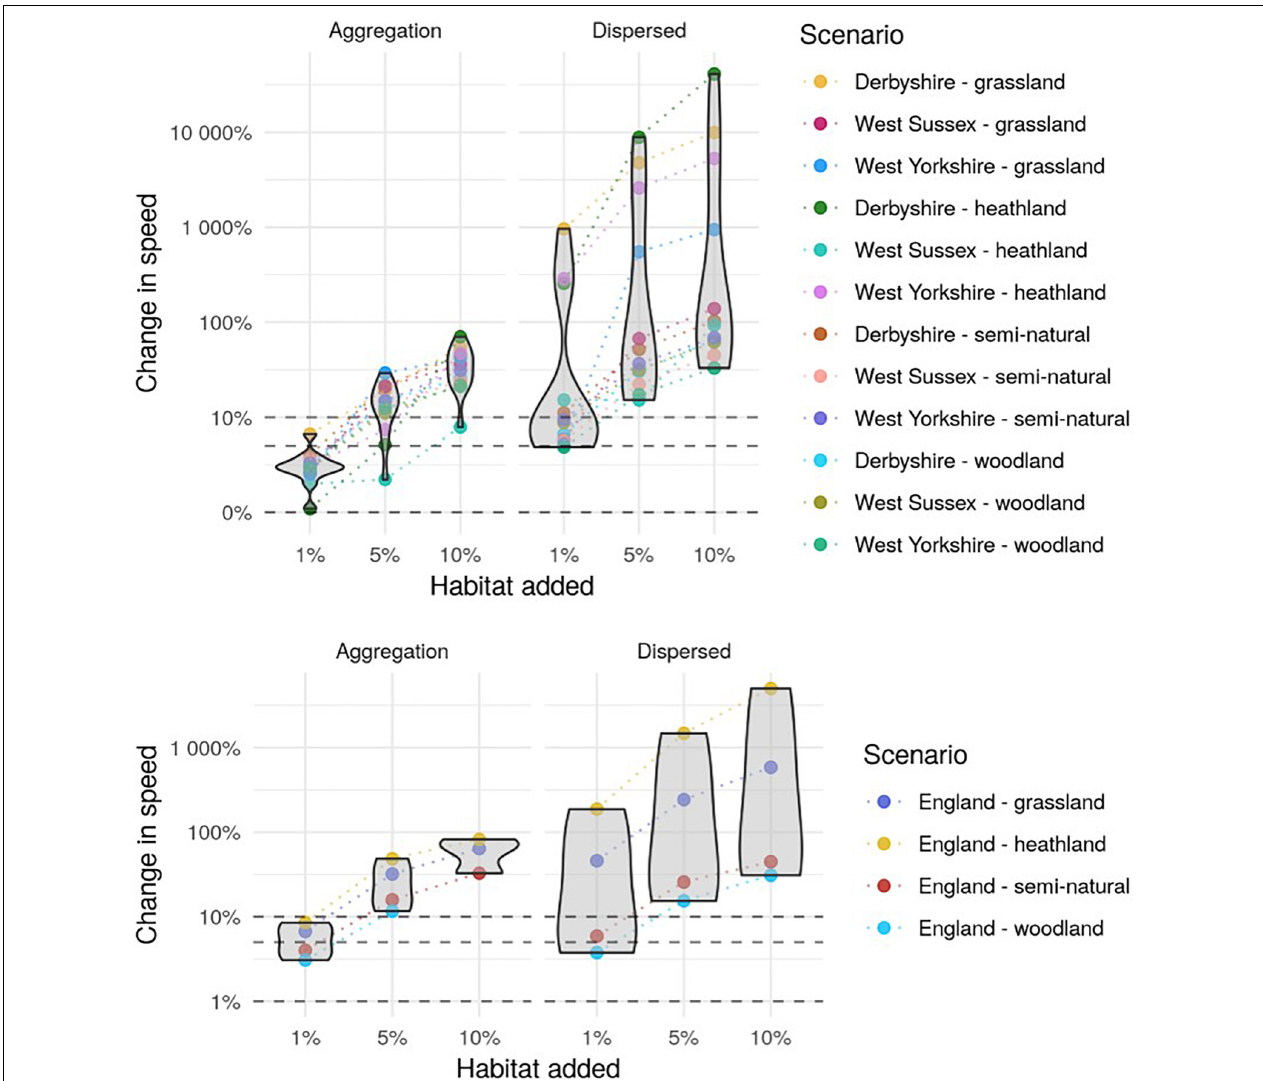
FIGURE 5 | Proportional increase in the speed metric for each of the simulated landscapes at the county scale (top) and England scale (bottom).The points are the proportional change in the metric from the baseline for each scenario, with dashed lines connecting the three levels of habitat addition. Violin plots show the distribution of the metric’s proportional change across habitats (for England) and habitat-counties combinations for each of the habitat addition amounts and spatial arrangement. The width of the violin represents the approximate frequency of data points in each region. Dashed lines indicate a 1, 5, and 10% change in the metric. The y axis is on the log10